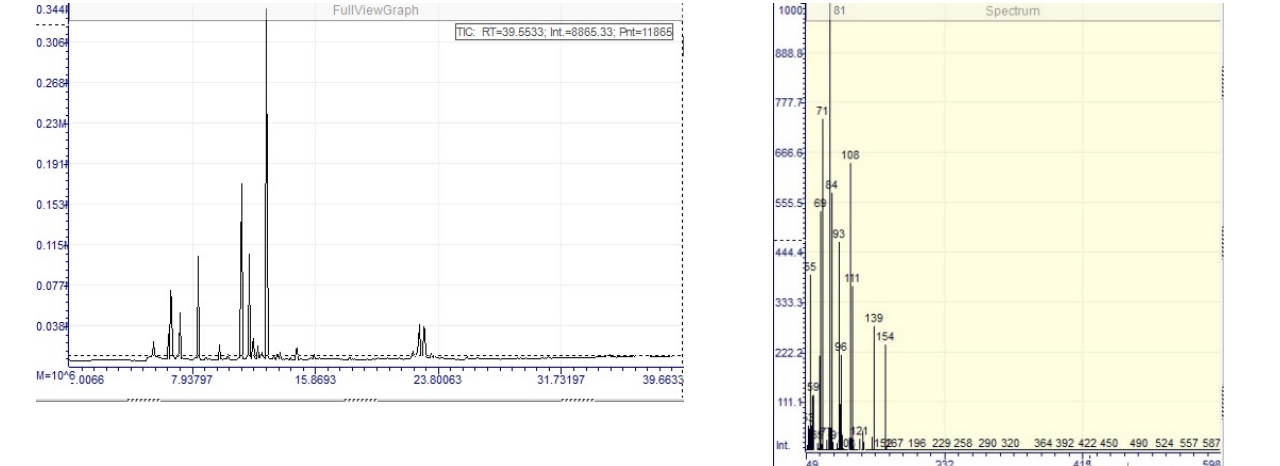
Table 3. Polyphenols content and antioxidant activity of the fresh young shoots R. officinalis tincture.